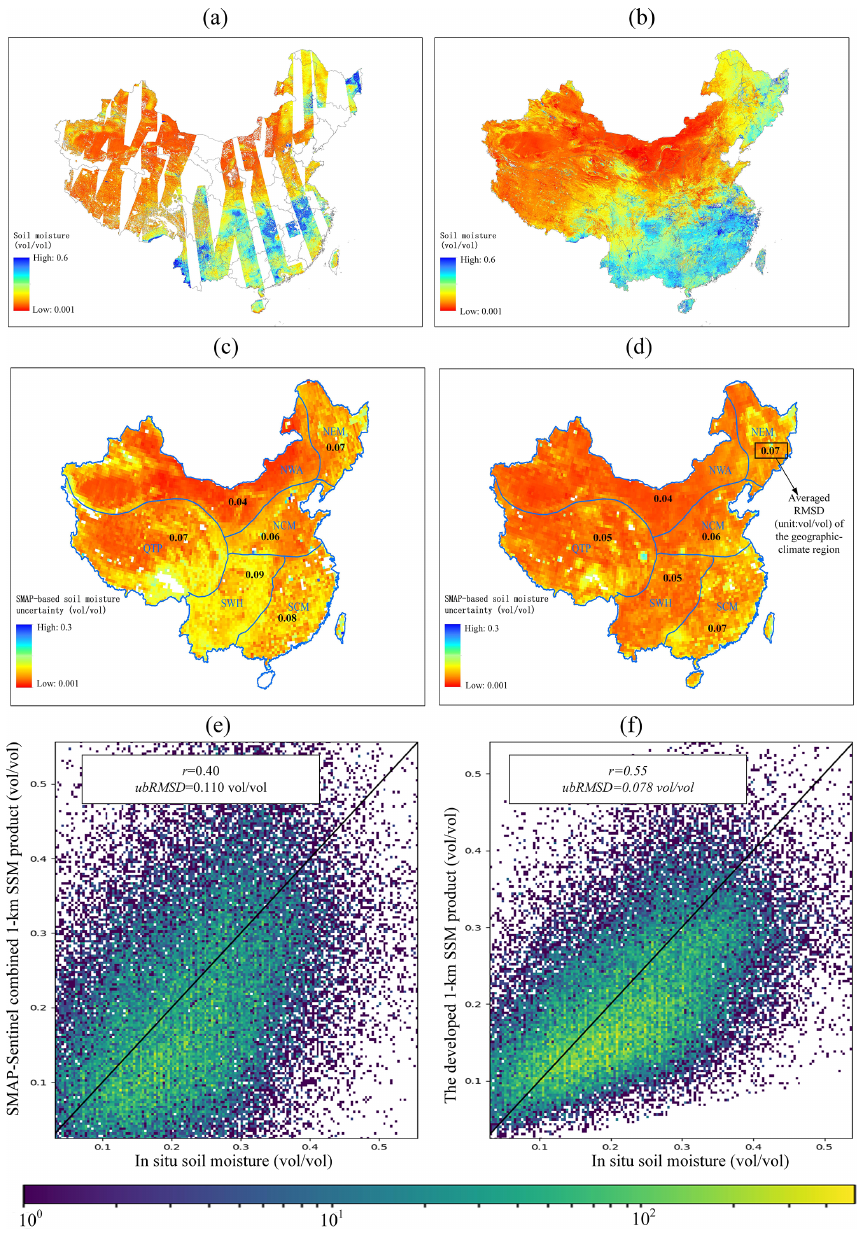
Figure 6. Comparison results between the currently developed 1km SSM product and the SMAP–Sentinel combined 1km SSM (SPL2SMAP_S_V3). (a) SPL2SMAP_S_V3 SSM images over the study area at about 06:00LT synthesized by six continuous dates from 26 to 31 May 2018. (b) The SSM image at 01:30LT of 29 May 2018 from the currently developed product. (c) Spatial uncertainty (RMSD) map of the SPL2SMAP_S_V3 product against SMAP radiometer-based SSM retrievals at the 36km pixel scale over the study area for the years 2017, 2018, and 2019. (d) Same as (c) but for the validation of the currently developed SSM product. The black numbers in each of the geographic–climate regions indicate averaged uncertainty (RMSD, unit: volvol − 1 ) of the region. (e) Validation results of the SPL2SMAP_S_V3 product against in situ soil moisture measurements over the study area for the years 2017, 2018, and 2019. The solid black line is the 1 : 1 line. (f) Same as (e) but for the validation of the currently developed SSM product.